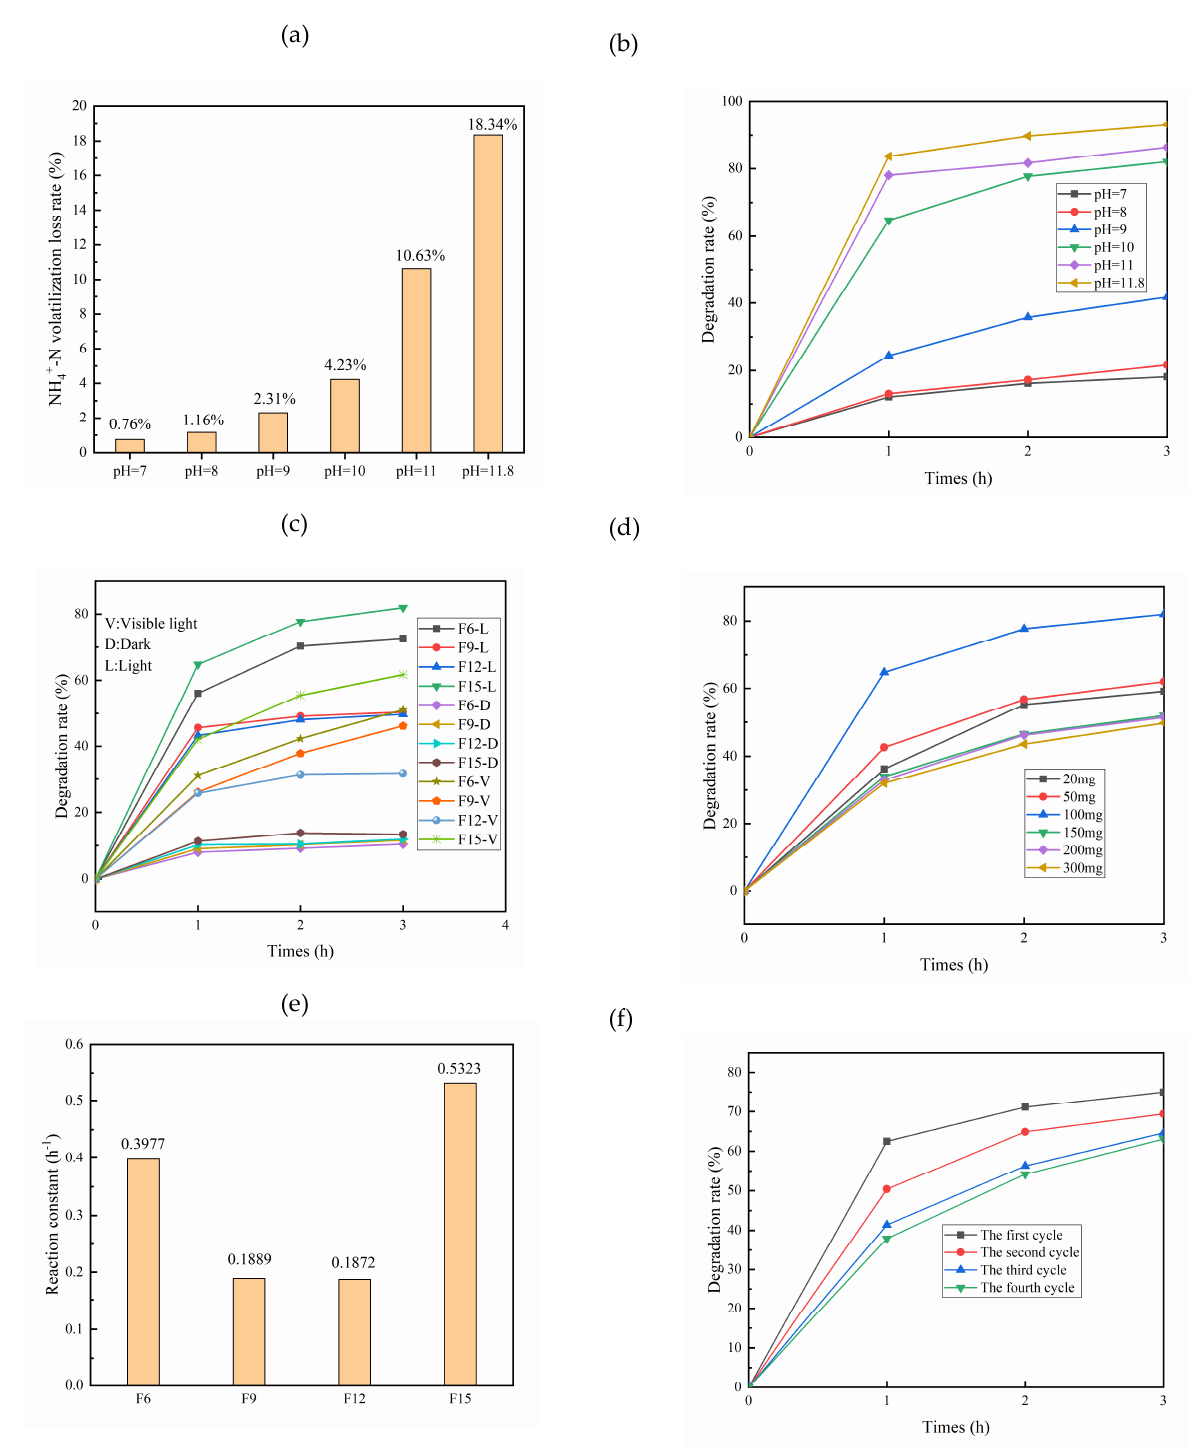
Figure 10. Volatilization loss of ammonia nitrogen at different pH ( a ), effect of pH on ammonia degradation ( b ), effects of different catalysts on ammonia degradation ( c ), effect of catalyst dosage on ammonia degradation ( d ), reaction constant of FX ( e ), repeated degradation property of F15 ( f ).